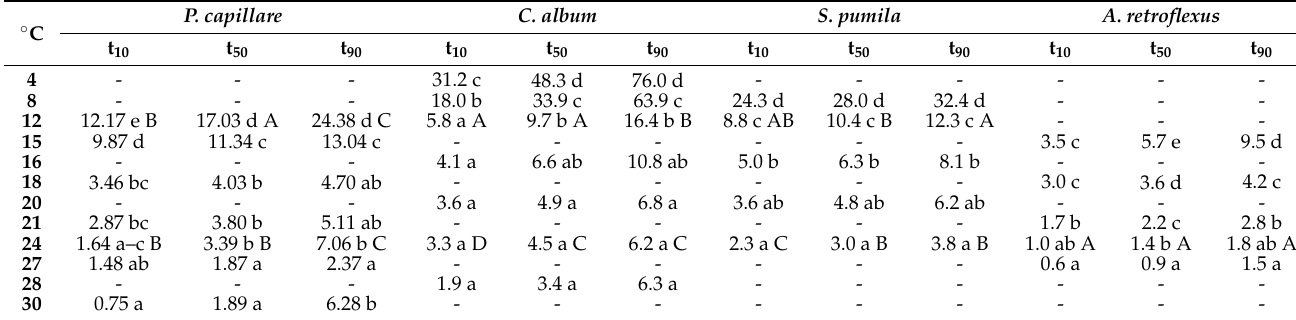
Table 1. Germination dynamics (t 10 , t 50 , and t 90 ) at the different studied temperatures.